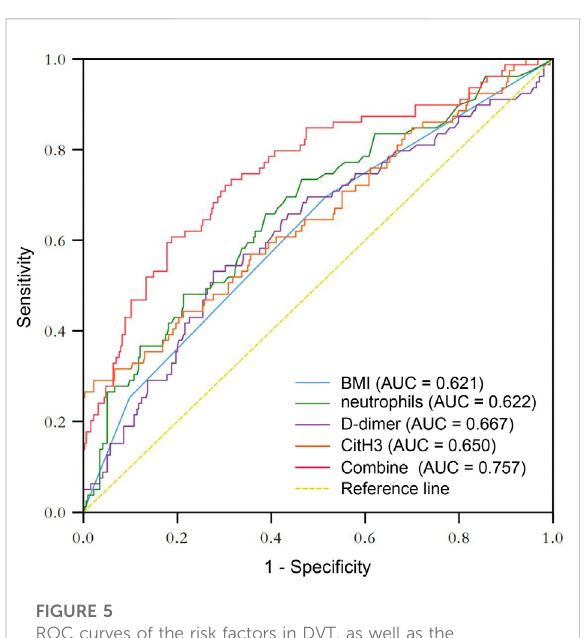
FIGURE 5 ROC curves of the risk factors in DVT, as well as the combination of these factors in predicting